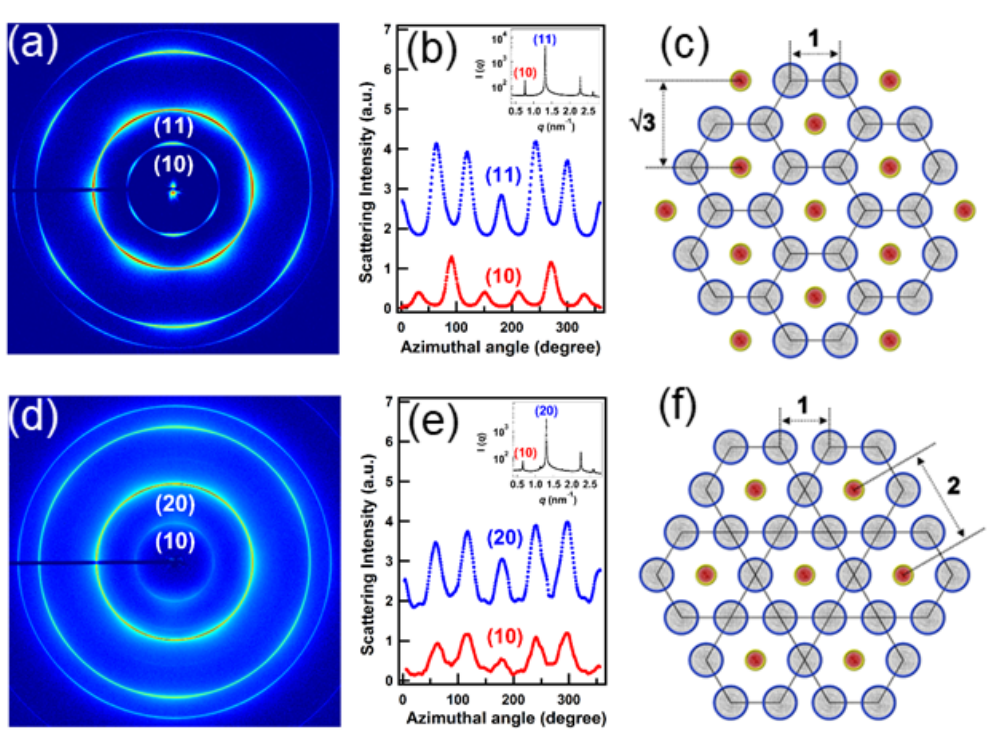
Figure 14. Shear-induced alignment of binary supperlattices formed by hexagonally packed cylindrical micelles of nonionic surfactants penta(ethylene glycol) monododecyl ether ( C 12 E 5 ) in water and rod-like micelles of polymerizable cationic surfactants, n-alkyltrimethylammonium 4-vinylbenzoate ( C n TVB, with alkyl chain length, n = 10, 12, 14 or 16. ( a ) Oriented SAXS pattern along the flow direction for p − C 14 TVB / C 12 E 5 /water (10/45/55 weight ratio). ( b ) Azimuthal variation of intensities along the (10) √ and (11) reflections (which make the peak position ratio of 1: 3) for AB 2 type structure. Inset shows the azimuthally averaged intensity. ( c ) Schematic representation of a AB 2 type binary superlattice with an hexagonal array of p − C n TVB rods (smaller spots) intercalated in an honeycomb lattice of C 12 E 5 cylinders. ( d ) Oriented SAXS pattern along the flow direction for p − C 10 TVB / C 12 E 5 /water (5/45/55 weight ratio). ( e ) Azimuthal distribution of intensities along the (10) and (20) reflections (which make the peak position ratio of 1:2) for AB 3 type structure. Inset displays the azimuthally averaged intensity. ( f ) Schematic representation of a AB 3 type binary superlattice in which an hexagonal lattice of p − C 10 TVBs is embedded in a kagome lattice of C 12 E 5 cylinders (larger spots). Adapted from